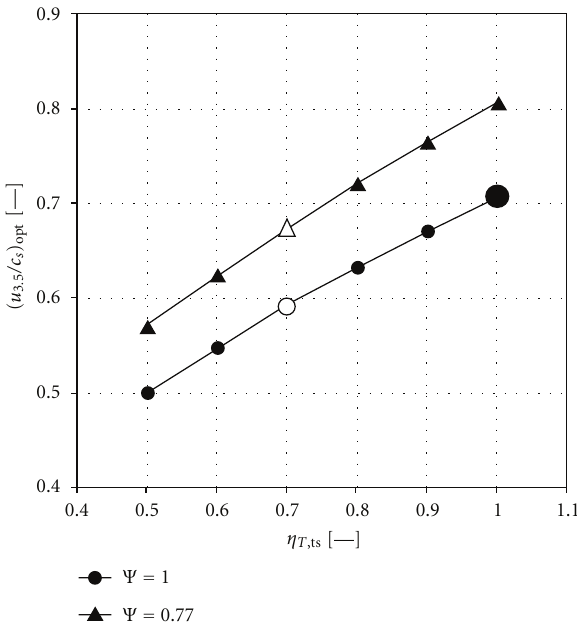
Figure 7: Optimum u 3 . 5 /c s versus assumed stage e ffi ciency for two di ff erent blade